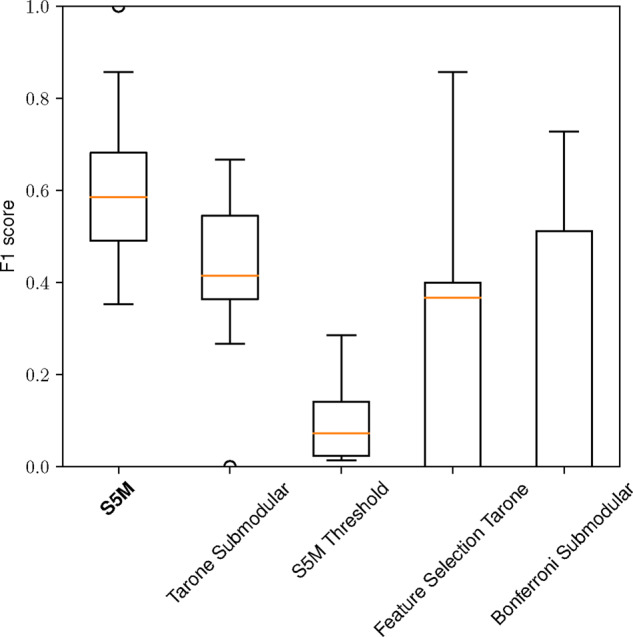
Comparing the F1 score of alternative strategies for extracting representative statistically significant shapelets on a simulation dataset varying the noise added to the prototype sequence and number of time series. S5M significantly outperforms its competitors (P < 0.005 with Welch’s t-test)